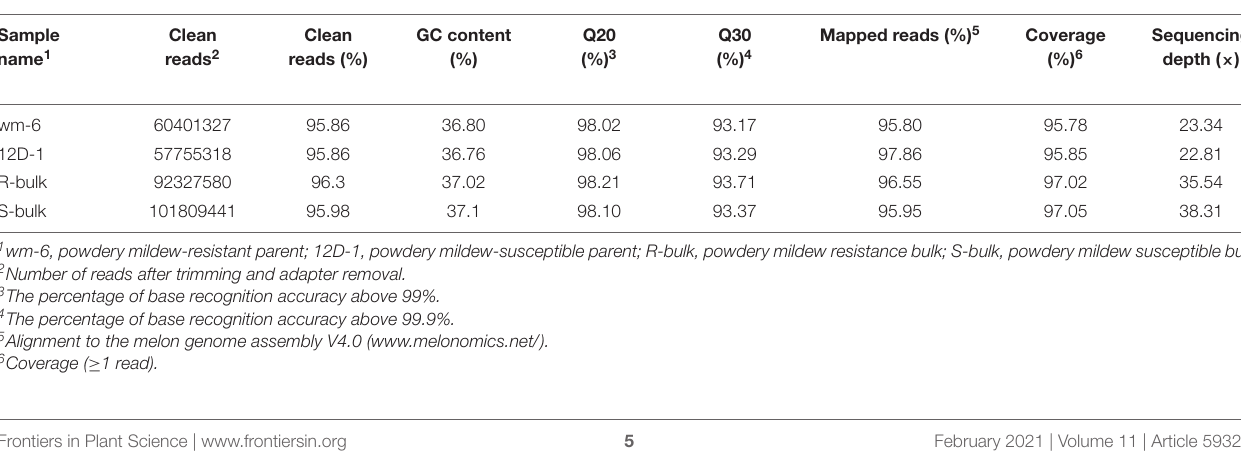
TABLE 2 | Summary of sequencing data and the data aligned to the melon reference genome for the parental lines and the resistant and susceptible pools by